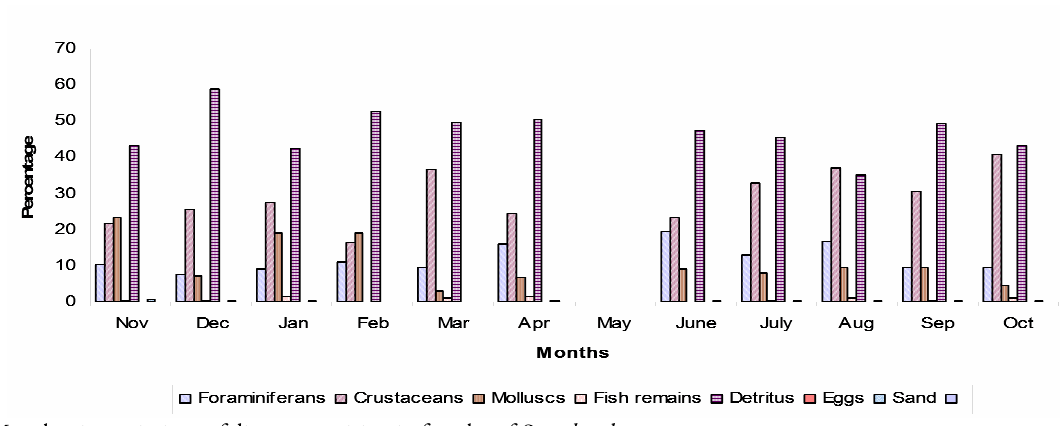
Fig. 4. Month-wise variations of diet composition in females of S. melantho